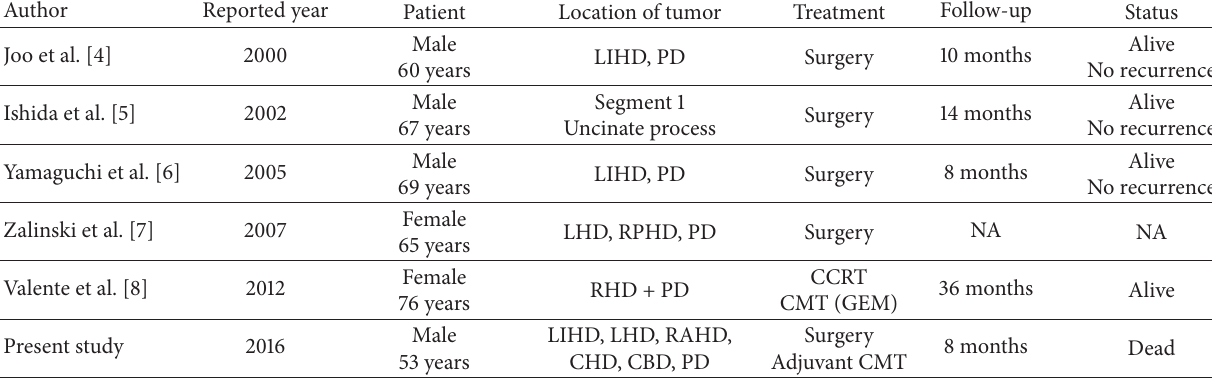
Table 1: Reported cases of simultaneous intraductal papillary neoplasm of the bile duct and pancreas.